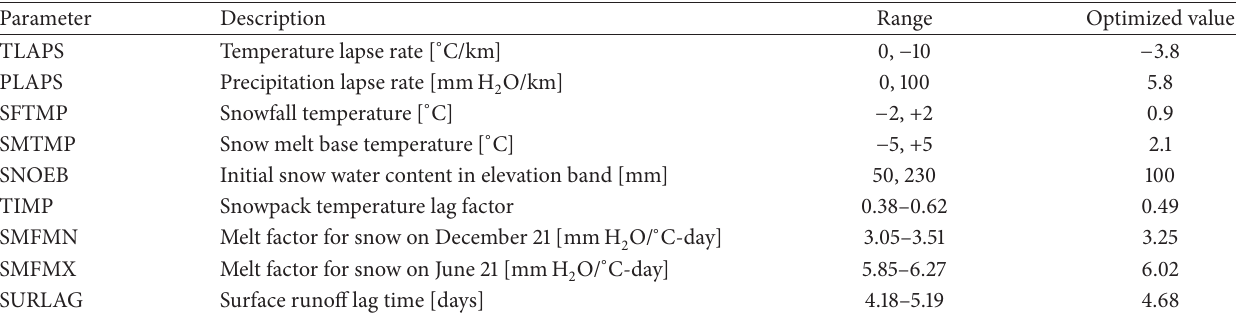
Table 3: List of calibration parameters and the optimized